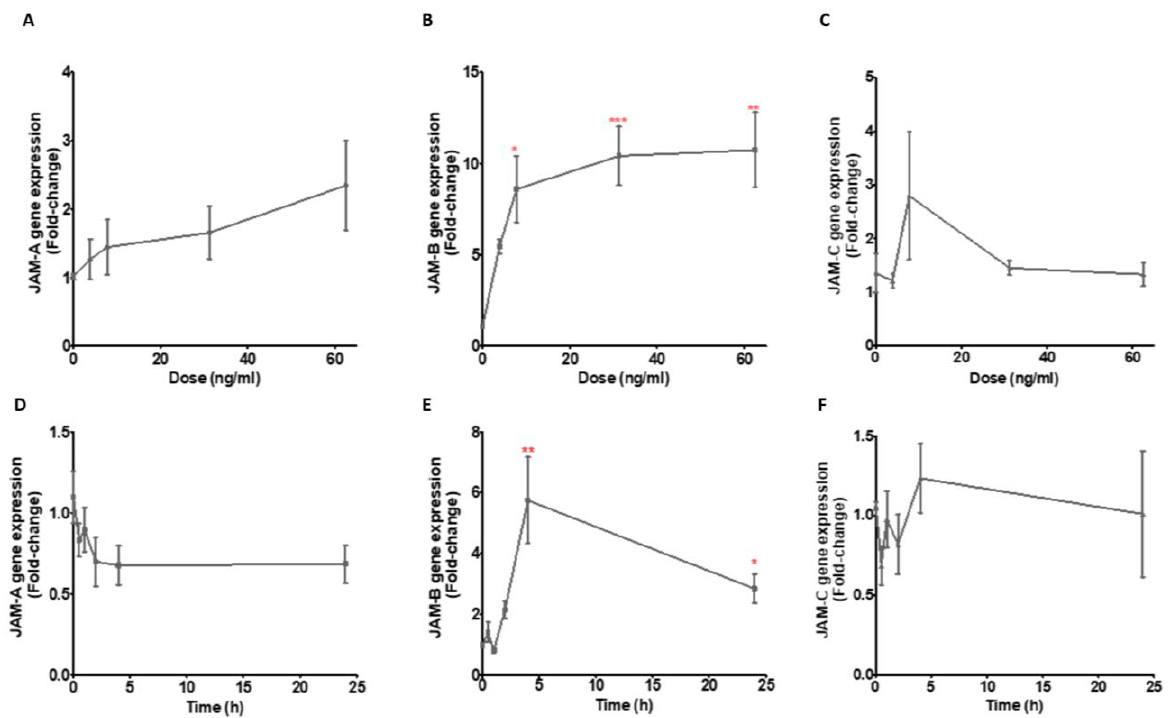
Figure 3. Gene expression responses of the JAMs to varying LPS doses relative to the geometric mean of YWHAZ and ACT-β expression ( A – C ) and to 10 ng/mL LPS over a 24 h time course with sampling at 0, 0.5, 1, 2 and 4 h and then at 24 h in THP-1 monocytes ( D – F ). ( A , D ) JAM-A gene expression, ( B , E ) JAM-B gene expression and ( C , F ) JAM-C gene expression. The comparisons in ( A ) to ( C ) are between the control without LPS and the different LPS doses while those in ( D ) to ( C ) are between expression at time 0 and at various times. *** indicates p ≤ 0.0001, ** indicates p ≤ 0.001, * indicates p ≤ 0.05.